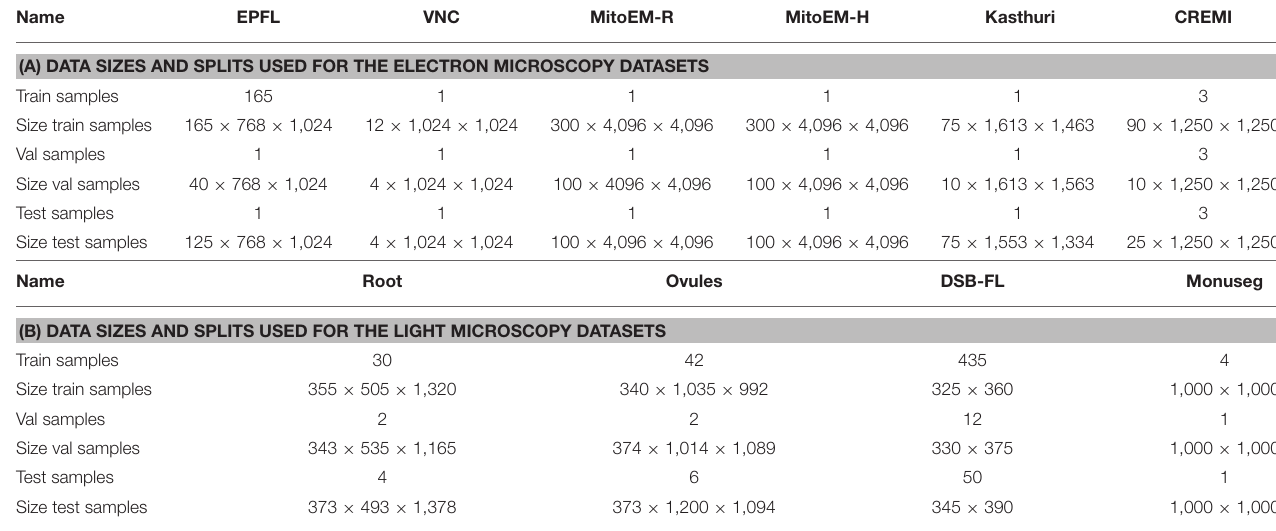
TABLE A1 | The number of samples used for train, validation and test splits as well as the size of one of the sample in pixels.